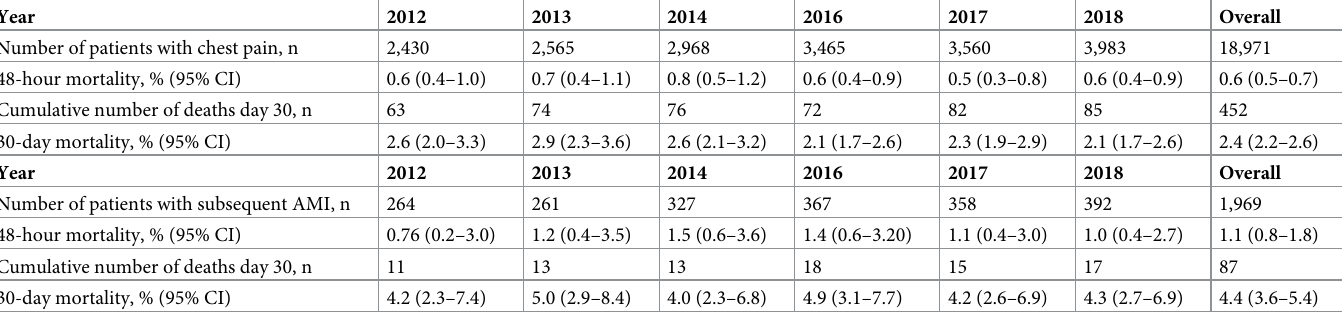
Table 3. Cumulative deaths and mortality estimates for patients with chest pain, and those with a subsequent AMI diagnosis. Cumulative number of deaths within 48-hours omitted due to microdata. AMI, acute myocardial infarction.